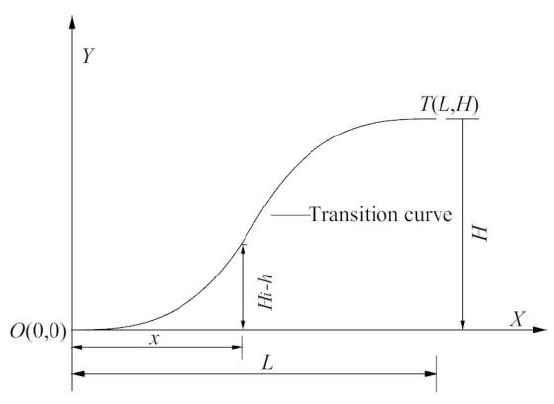
Figure 3. Terrain transition curve.